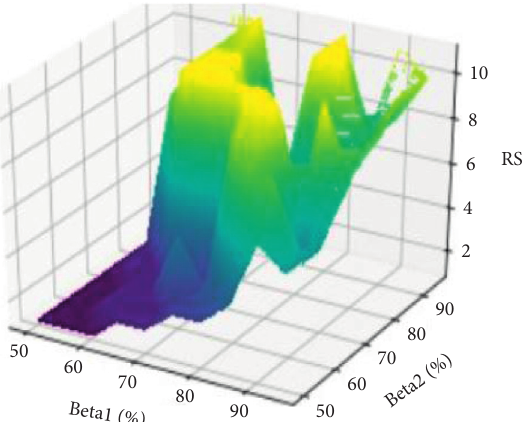
Figure 18: beta1, beta2 vs. RSUs.